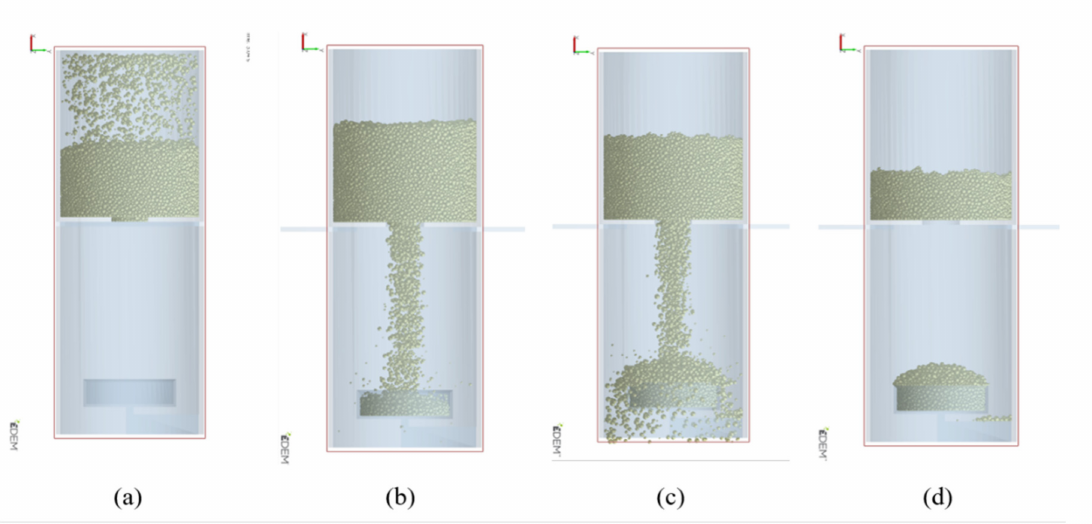
Figure 3. Working process of the sandglass test in EDEM: ( a ) Generating granular particles in the upper vessel; ( b ) coming out of the left and right plugs and filling the inner vessel; ( c ) falling of excess particles; ( d ) discharged upper vessel and particle flow formation onto the inner